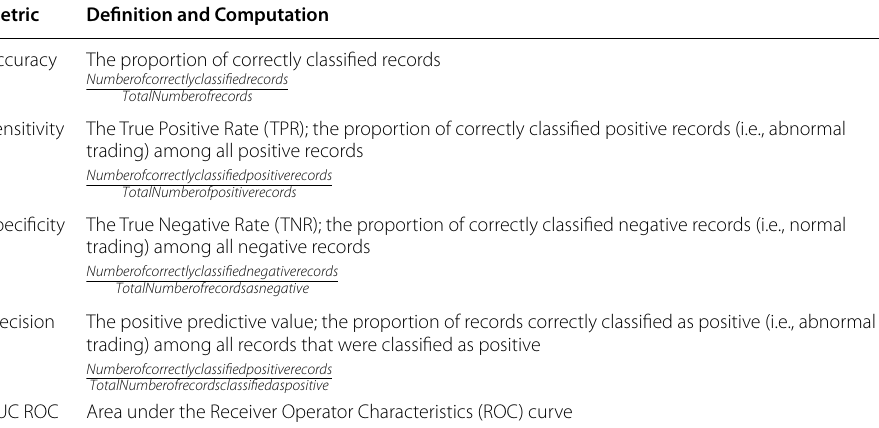
Table 6 Performance metrics definitions